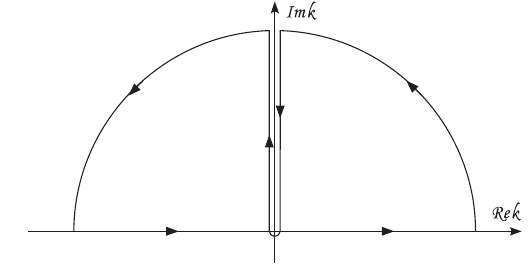
FIG. 3. Contour of free space impedance for (cid:14) > 0